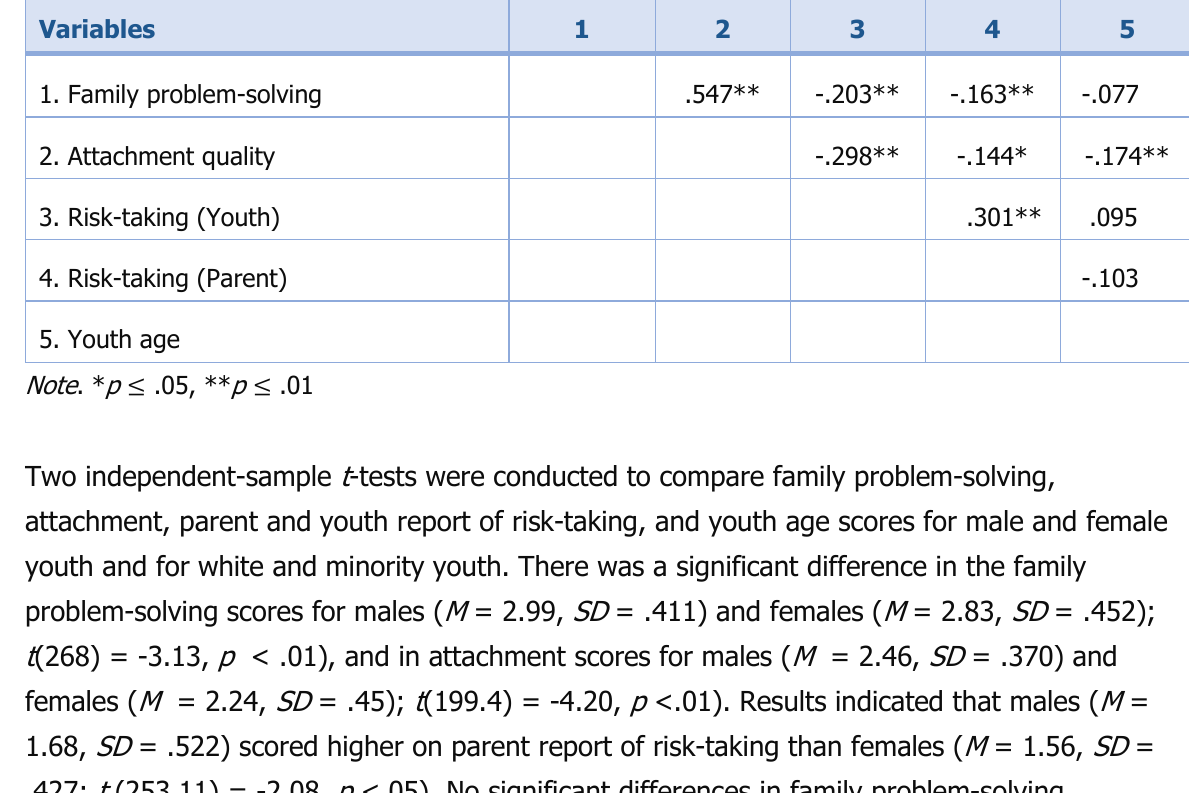
Table 2. Correlations Between Key Study Variables